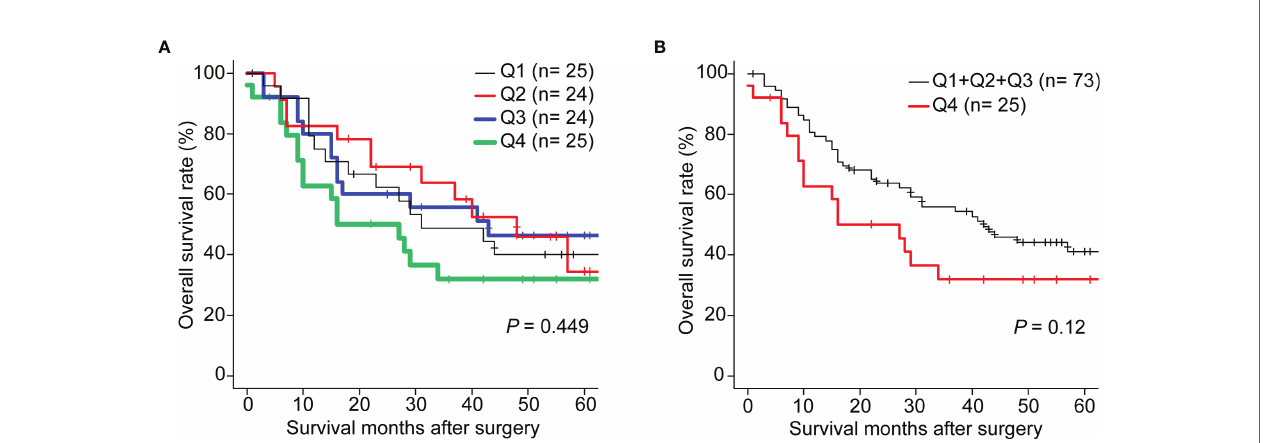
FIGURE 6 | Comparison of overall survivals of the patients with ESCC according to BRAT1-Abs levels. Kaplan-Meier plots are shown. The number of patients was shown in parentheses. (A) The BRAT1-Abs levels were classi fi ed into every one-fourth quartiles according to antigen level (Q1, Q2, Q3 and Q4). (B) The BRAT1-Abs levels were classi fi ed into two groups (Q1+Q1+Q3 vs. Q4). The p value at 60 months after surgery was 0.12. Log-Rank test was performed to compare the difference between two groups.